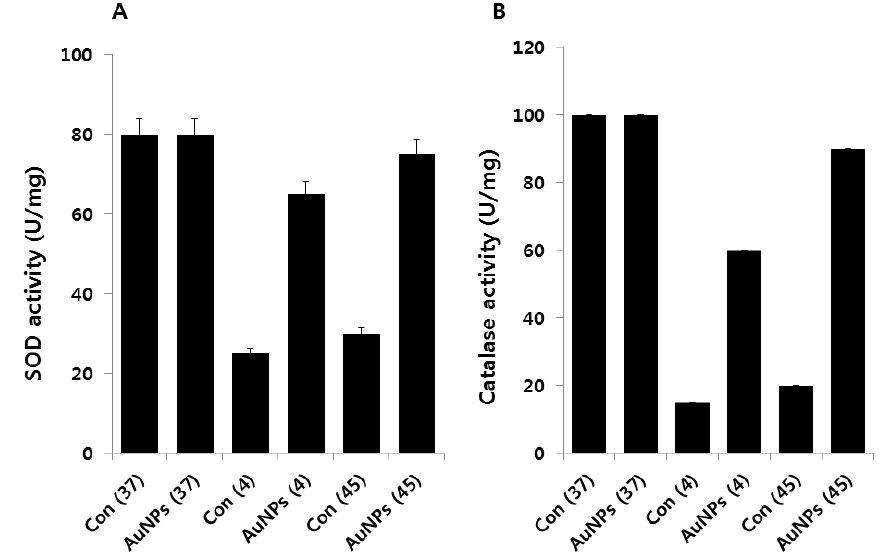
Figure 8. Effect of AuNPs on SOD and CAT activity. E. coli cells were pre-incubated with